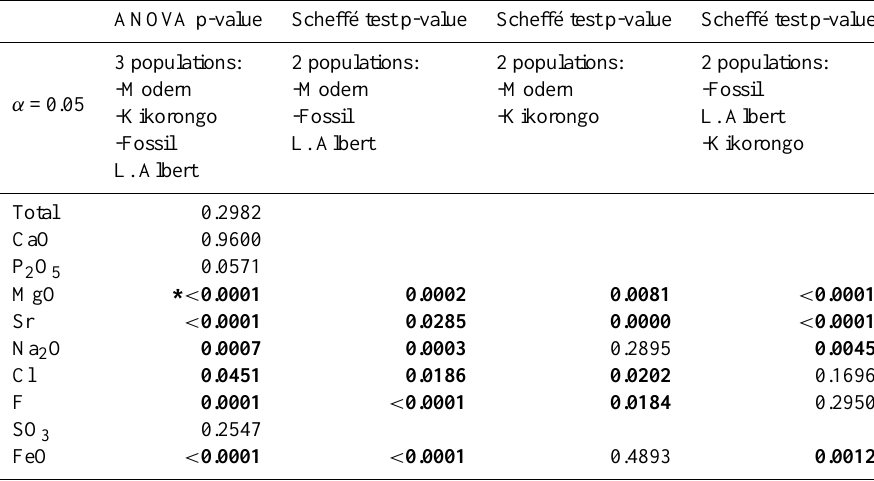
Table 5. One Factor analysis of variance (ANOVA) of molar enamel and Scheff´e tests distinguishing modern, Lake Kikorongo and fossil Lake Albert populations. ANOVA p-value Scheff´e test p-value Scheff´e test p-value 2 populations: 2 populations: -Modern -Modern -Modern -Fossil -Fossil